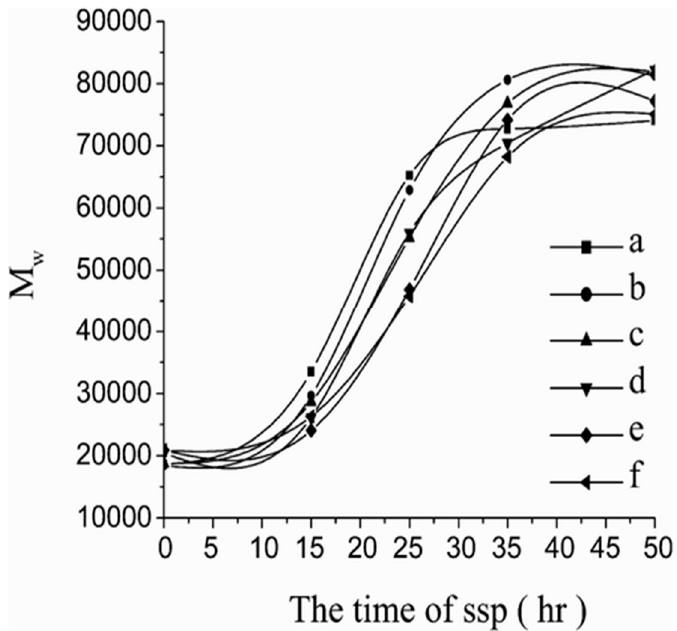
Figure 4. The molecular weight of PLLA prepolymers crystallized for various times as a function of SSP time ( a ) crystallized for 15 min, ( b ) crystallized for 30 min, ( c ) crystallized for 45 min, ( d ) crystallized for 60 min, ( e ) crystallized for 75 min, and ( f ) crystallized for 90 min. [91]. Reprinted with permission from ref. [90]. Copyright 2006